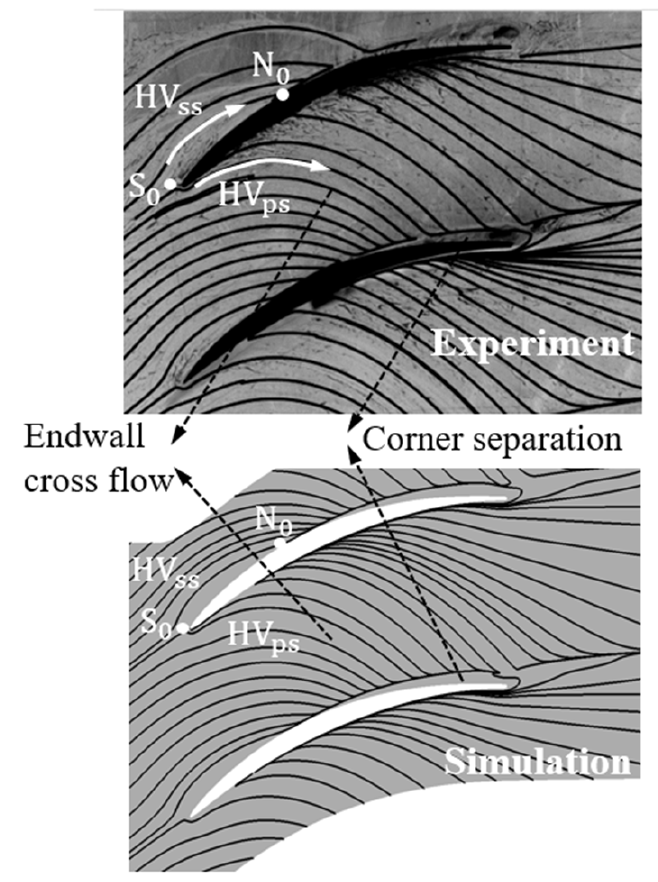
Figure 7. Comparison of the endwall limiting streamlines of simulation and experiment in the original cascade at design condition.